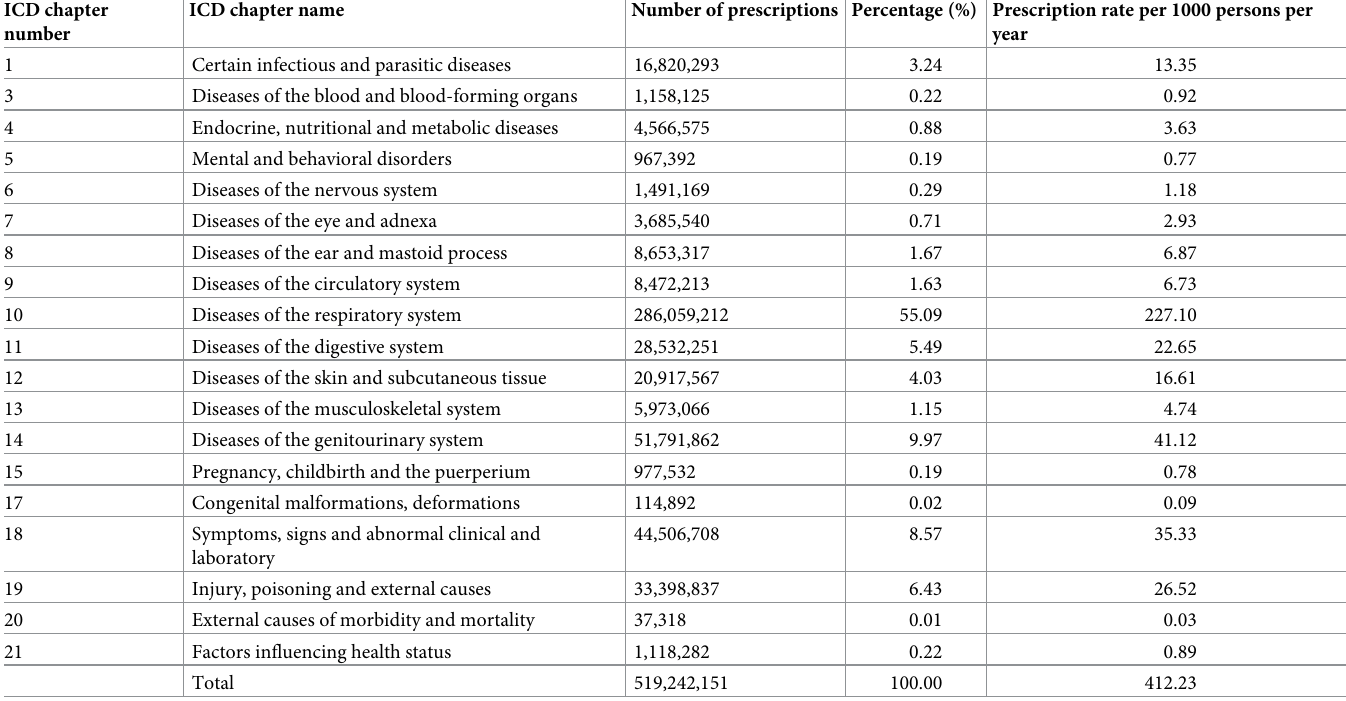
Table 1. Distribution of outpatient antibiotic prescriptions in India, by disease conditions, 2013–2014. ICD chapter